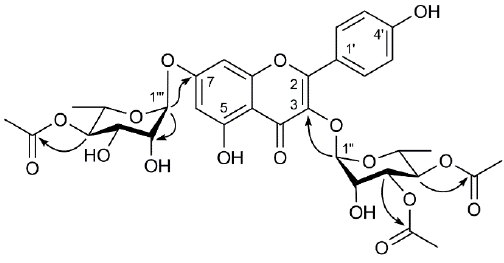
Figure 2. Key HMBC correlations of compound 1 .